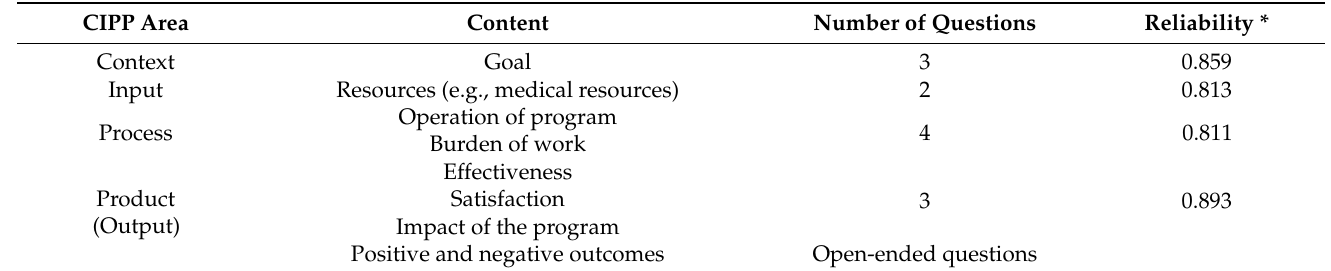
Table 1. Doctors’ CIPP questionnaire content areas in the Follow-up Health Consultation Program evaluation.